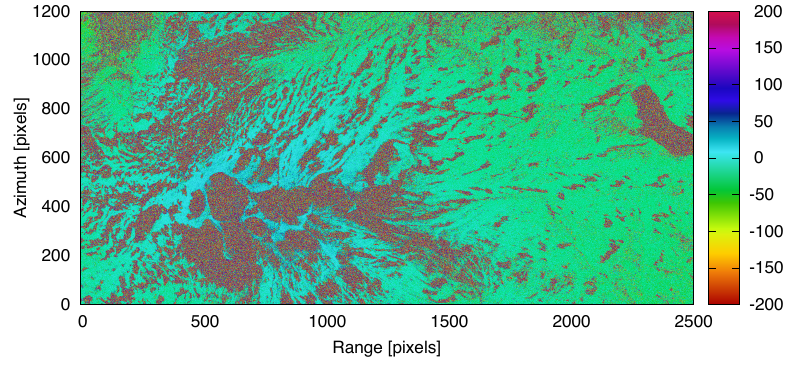
Figure 4. Phase measured with Split-Band Interferometry over Copahue volcano. Color chart values are given in